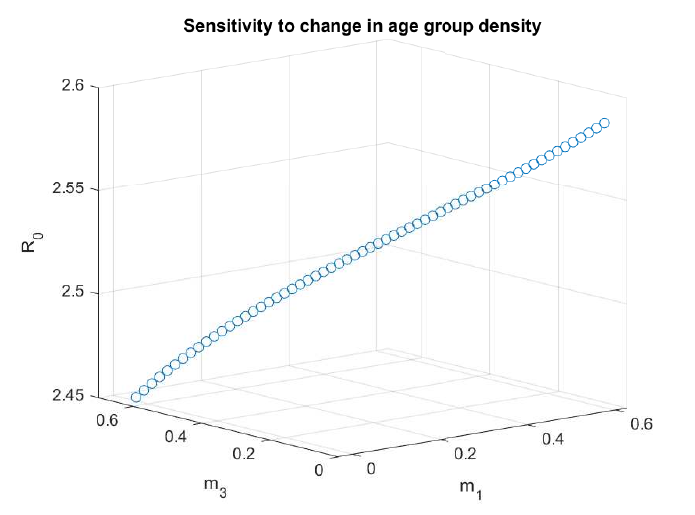
Figure 6. Change in R 0 based on the proportion of age